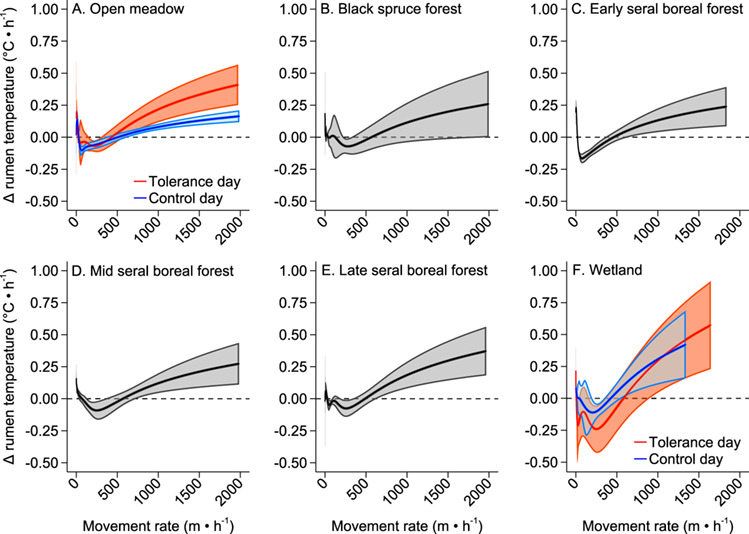
Rate of change in rumen temperature (°C • h−1) by movement rate (m • h−1) and daily thermoregulatory response within each habitat type (A–F) for captive adult female moose (n = 6) at the Kenai Moose Research Center, Kenai Peninsula, Alaska, USA from May through August 2015. Tolerance days were those days when individual moose had a daily amplitude in body temperature ≥1.2°C. Control days were the day prior and the day after a tolerance day. Predicted values with 95% confidence intervals from mixed-effect model regression.